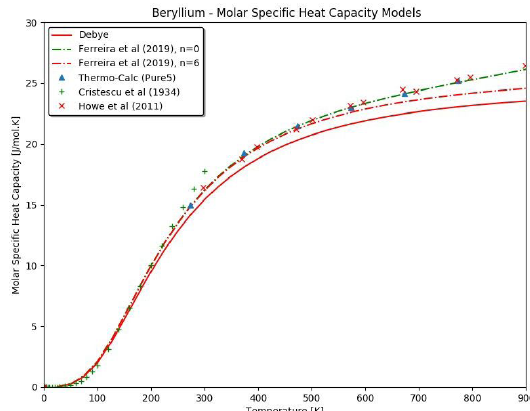
Figure 5. Comparison of the molar heat capacity of pure Be by carrying out Debye, Thermo-Calc, Ferreira’s model, and experimental data for low-temperature Cristescu and Simon 32 and high-temperature Howe et al. 33